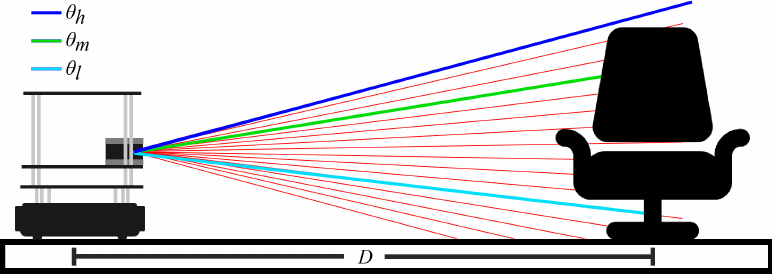
Figure 6. An illustrative example of the segmentation based on the angle for a chair sensed by a 3D LiDAR. Different colors highlight the three reference angles used for